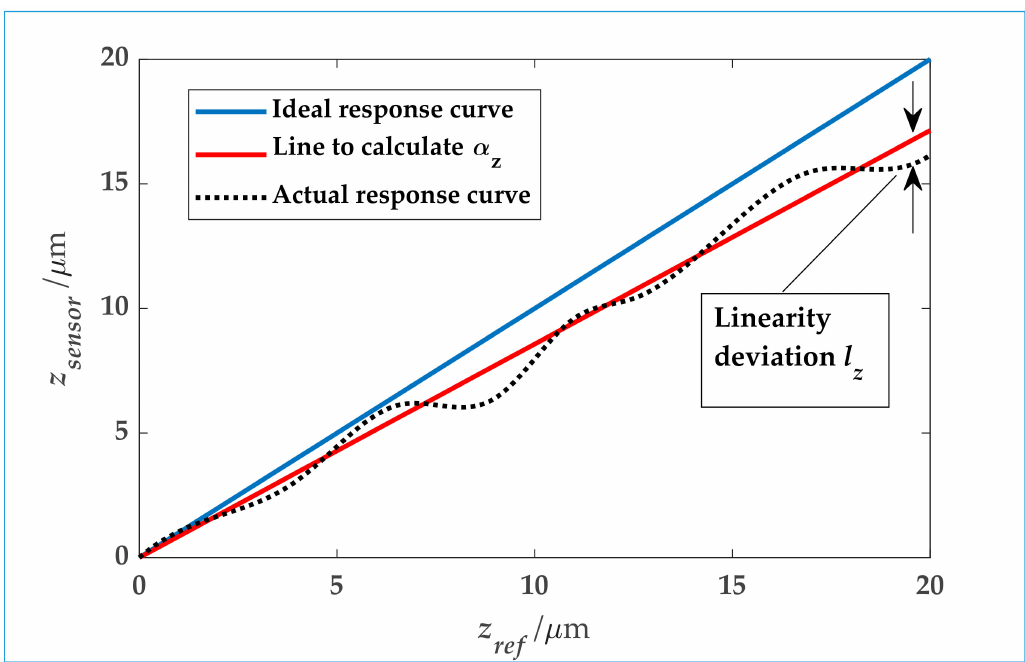
Figure 2. Example of a response curve and the derivation of amplification factor and linearity